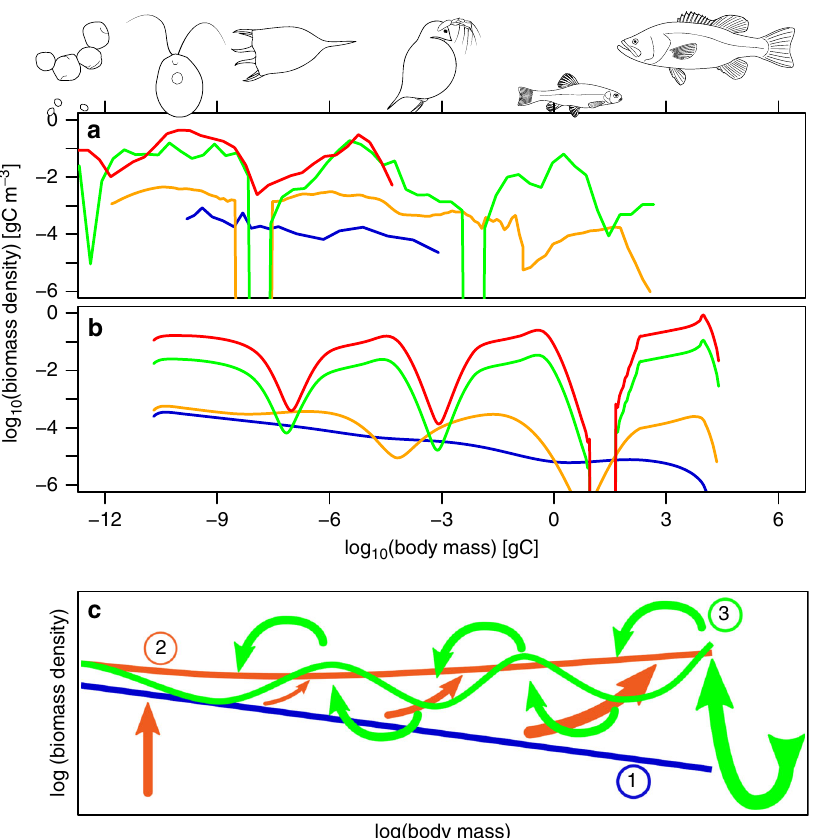
Fig. 1 Illustration of dome formation in size spectra. Empirical size spectra in panel a are, in order of increasing nutrient enrichment (lowest to highest line), from the North Paci fi c 33 (blue), Lake Superior 27 (orange), Lake Ontario 86 (green) and Lake Müggelsee 83 (red). See Methods for the representation of size spectra used. Comparable simulation data in panel b are steady states of the Species Size Spectrum Model (SSSM) with varying eutrophication parameter x (lowest to highest line; blue: x = 1, orange: 10 0.2 = 1.58, green: 10 1.6 = 39.8, red: 10 2.4 = 251). Panel c illustrates the causal chain generating domes in the SSSM. ① At low nutrient supply, the size-spectrum forms an approximate straight line on double-logarithmic axes (blue line). ② Increasing nutrient supply increases abundance of primary producers, and, through bottom-up trophic ampli fi cation, induces an upward-bending of the entire size-spectrum (orange line and arrows). ③ As a result, consumers become more satiated and more abundant relative to their resources, which both acts to amplify top-down cascades 4,13 . Low-predation mortality of the top predators induces such a cascade. This leads to formation of several domes along the size spectrum (green line and